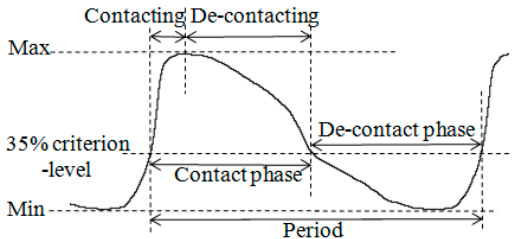
Figure 1. The landmarks in the EGG signal.